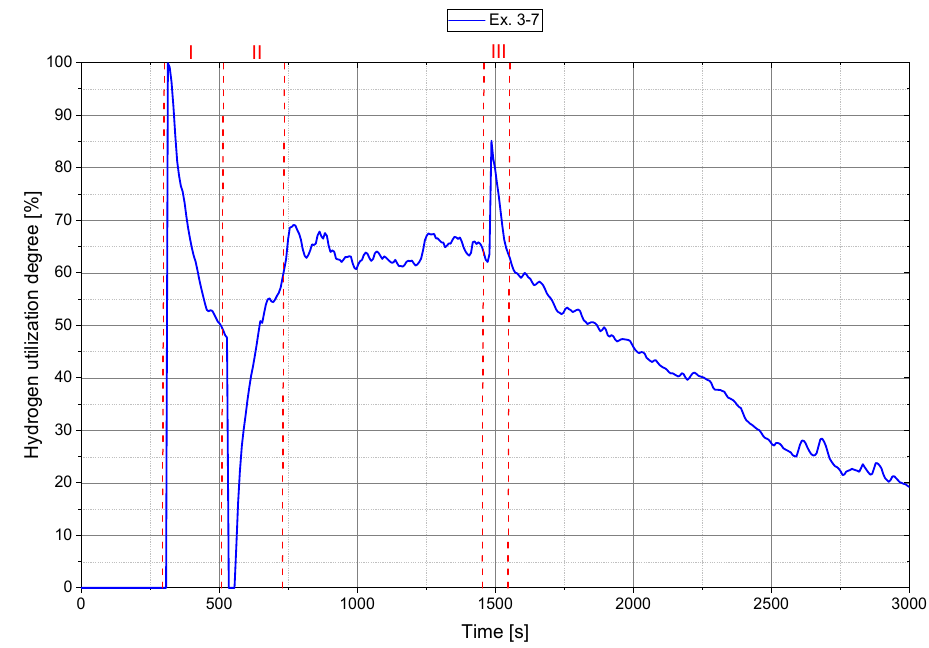
Figure 10. Trend of the hydrogen utilization degree for Ex. 3–7.